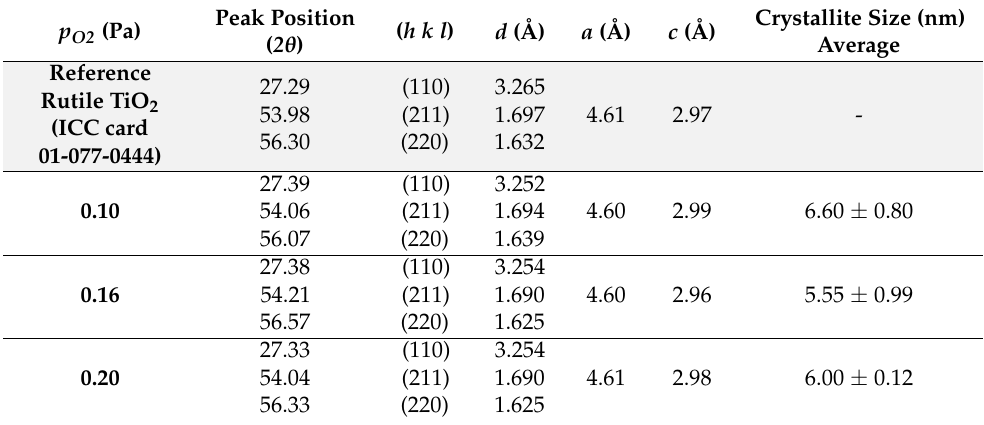
Table 2. Peak position, crystal planes, interplanar spacing, and lattice constants for TiO 2 rutile reference cards and for samples in group